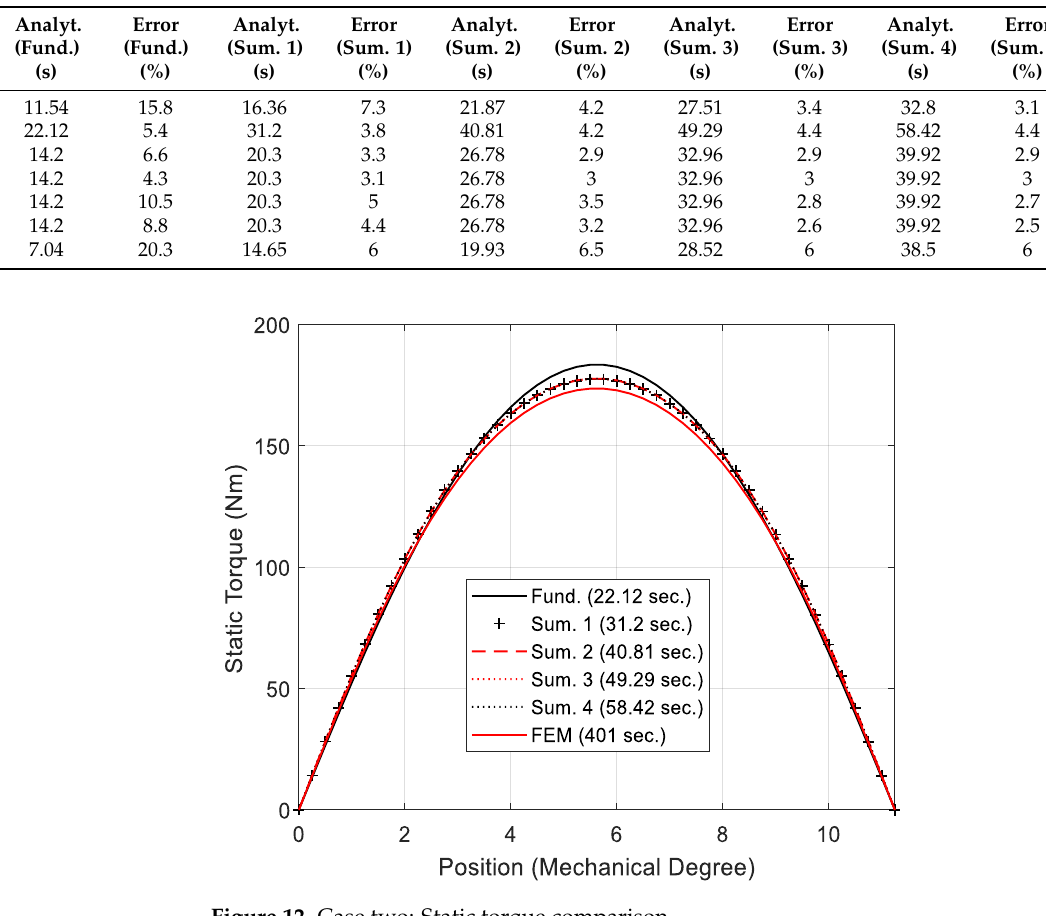
Figure 13. Case four: Static torque comparison.